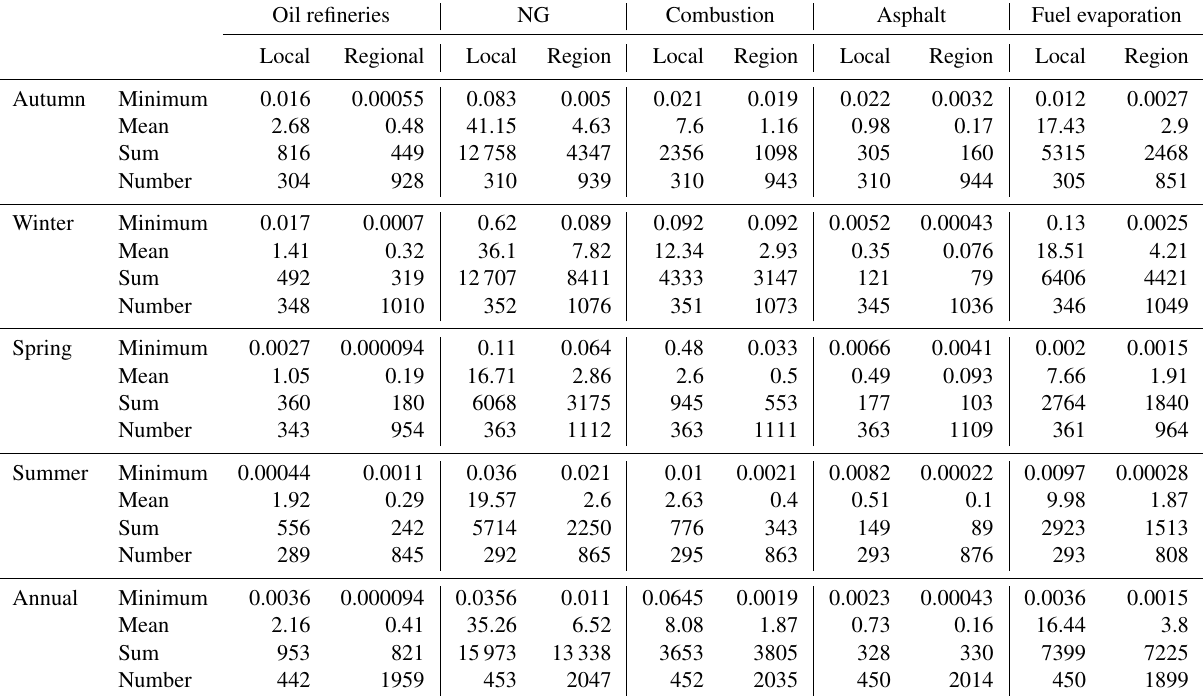
Table C1. The statistics of VOC sources in each season obtained using raster analysis. Oil refineries NG Combustion Asphalt Fuel evaporation Local Regional Local Region Local Region Local Region Local Region Autumn Minimum 0.016